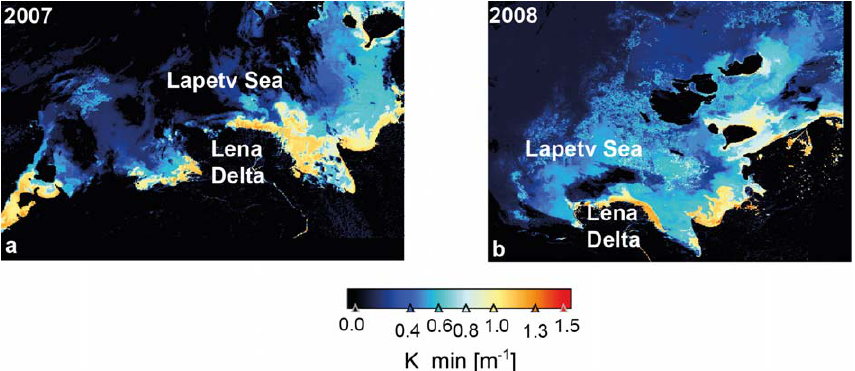
741 Fig. 6. ESA MERIS acquisition of the central southern Laptev Sea on 24 August 2007 (a) and 12 August 2008 (b) showing the different attenuation patterns in summer 2007 and 2008. The parameters are processed using MERIS Case 2 Regional C2R processor (attenuation: m − 1 ) . Land and clouds are masked in